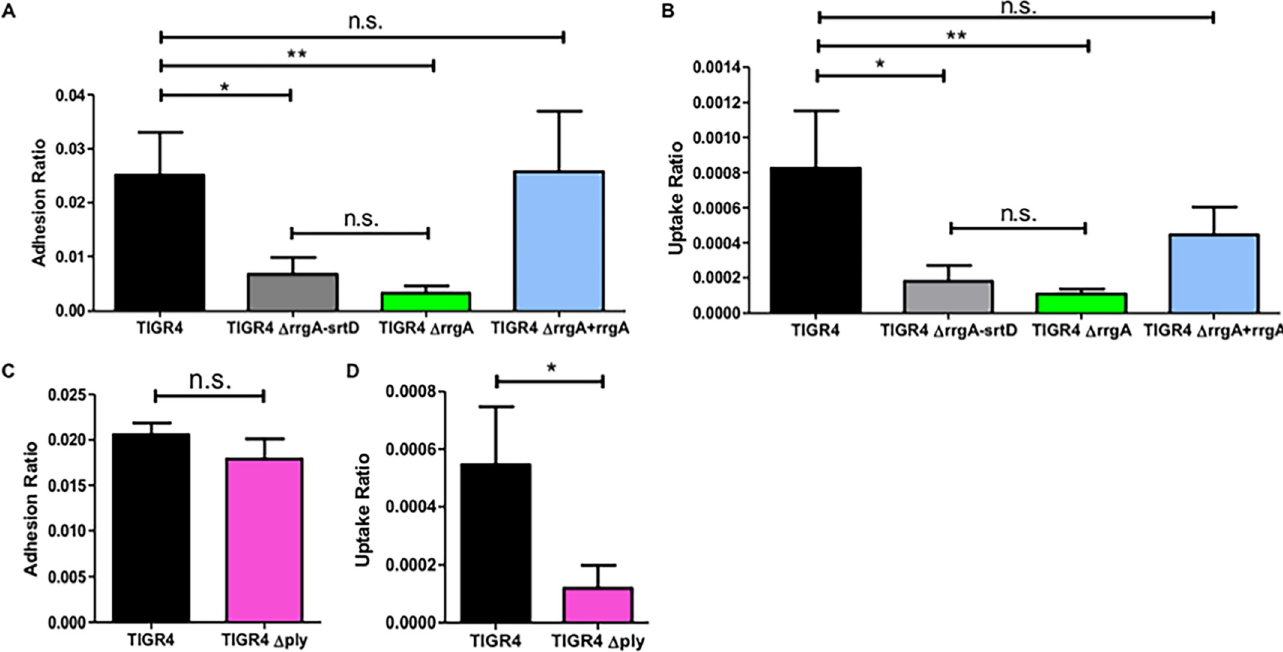
Fig 1. RrgA promotes pneumococcal binding to neurons, and both RrgA and Ply increases pneumococcal invasion into neuronal cells. Pneumococcal interaction with neurons was investigated in vitro using differentiated neurons and infection with (A and B) wt TIGR4 and its isogenic mutants, TIGR4 Δ rrgA - srtD , TIGR4 Δ rrgA , and TIGR4 Δ rrgA + rrgA , and in (C and D) wt TIGR4 and TIGR4 Δ ply . (A) CFU-based adhesion to neurons. (B) Invasion into neurons. (C) Adhesion ratio was calculated as [CFU of adhered bacteria] / [CFU of (non − adhered bacteria + adhered bacteria)]. (D) Invasion ratio was calculated as [CFU of invaded bacteria] / [CFU of adhered bacteria)]. For all graphs (A-D) the columns represent average values, and error bars represent standard deviations. Each graph shows an overview at least three (n � 3) biological replicates. �� = p < 0.001, � = p < 0.05, n.s. = non-significant.